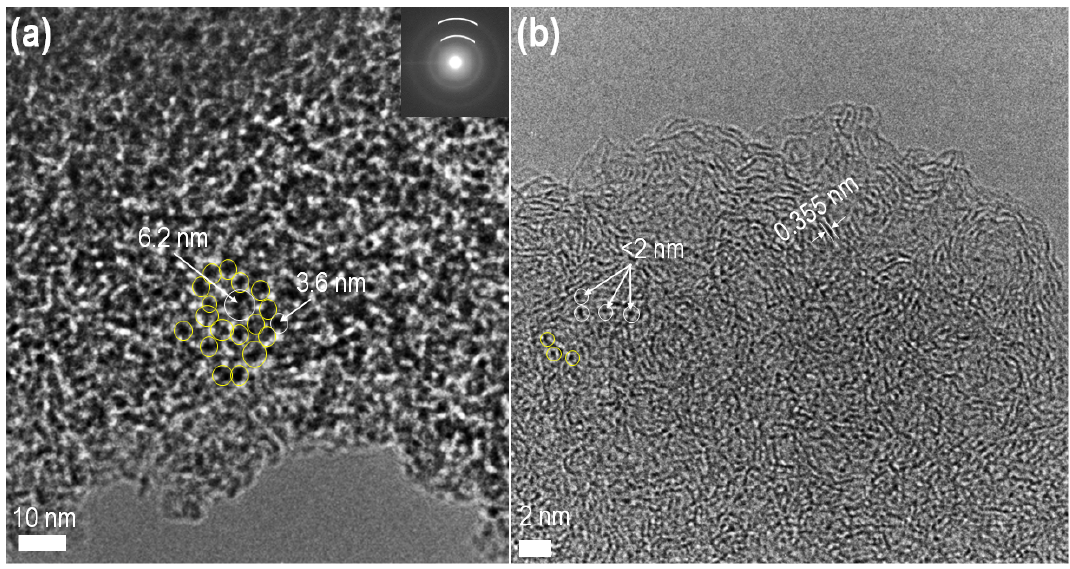
Figure 3. ( a ) Transmission electron microscope (TEM) image of LSC_1 as a typical example. ( b ) The corresponding high-resolution TEM (HR-TEM) image. Inset of panel ( a ) shows the selected area electron diffraction (SAED) pattern. Circles in panels ( a , b ) highlight mesopores and micropores, respectively.